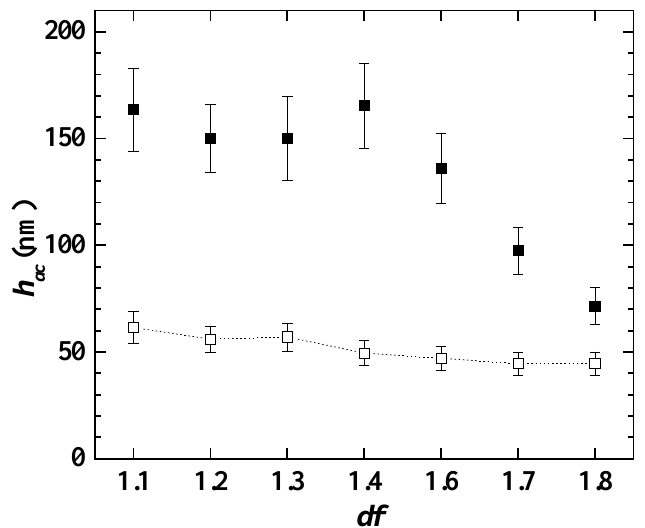
Figure 14. Acoustic thickness before (□) and after ( ■) rinsing/ dilution for the adsorption of model mixture at different values of df .